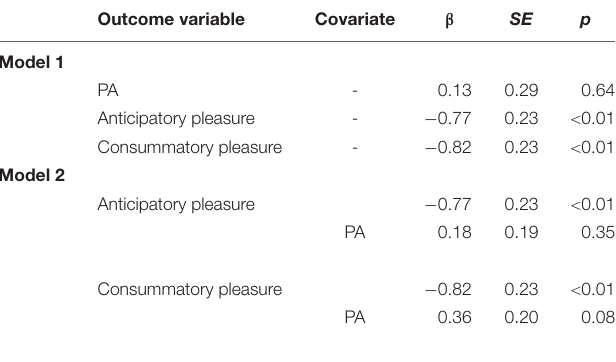
TABLE 2 | Estimates of positive affect (PA), anticipatory and consummatory pleasure in individuals with dysphoria compared with non-dysphoric individuals. Outcome variable Covariate